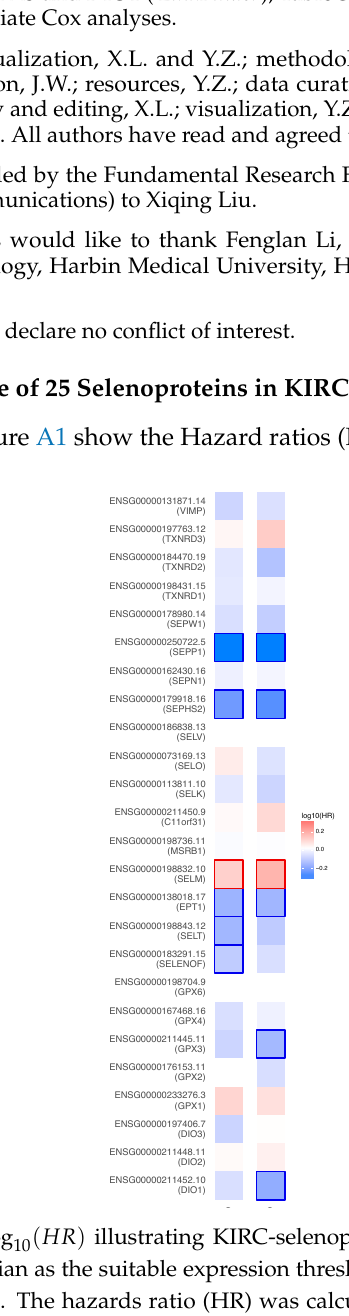
Table S1: Association results of GPX3 and DIO1 ( LinkFinder ), Table S2: Most survival genes in KIRC (GEPIA2) , Table S3: Univariate and multivariate Cox analyses.